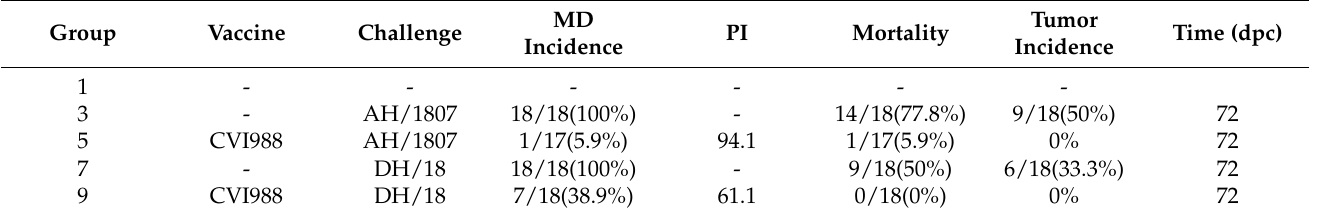
Table 3. Morbidity, mortality, and tumor rates of Marek’s disease (MD) by group.